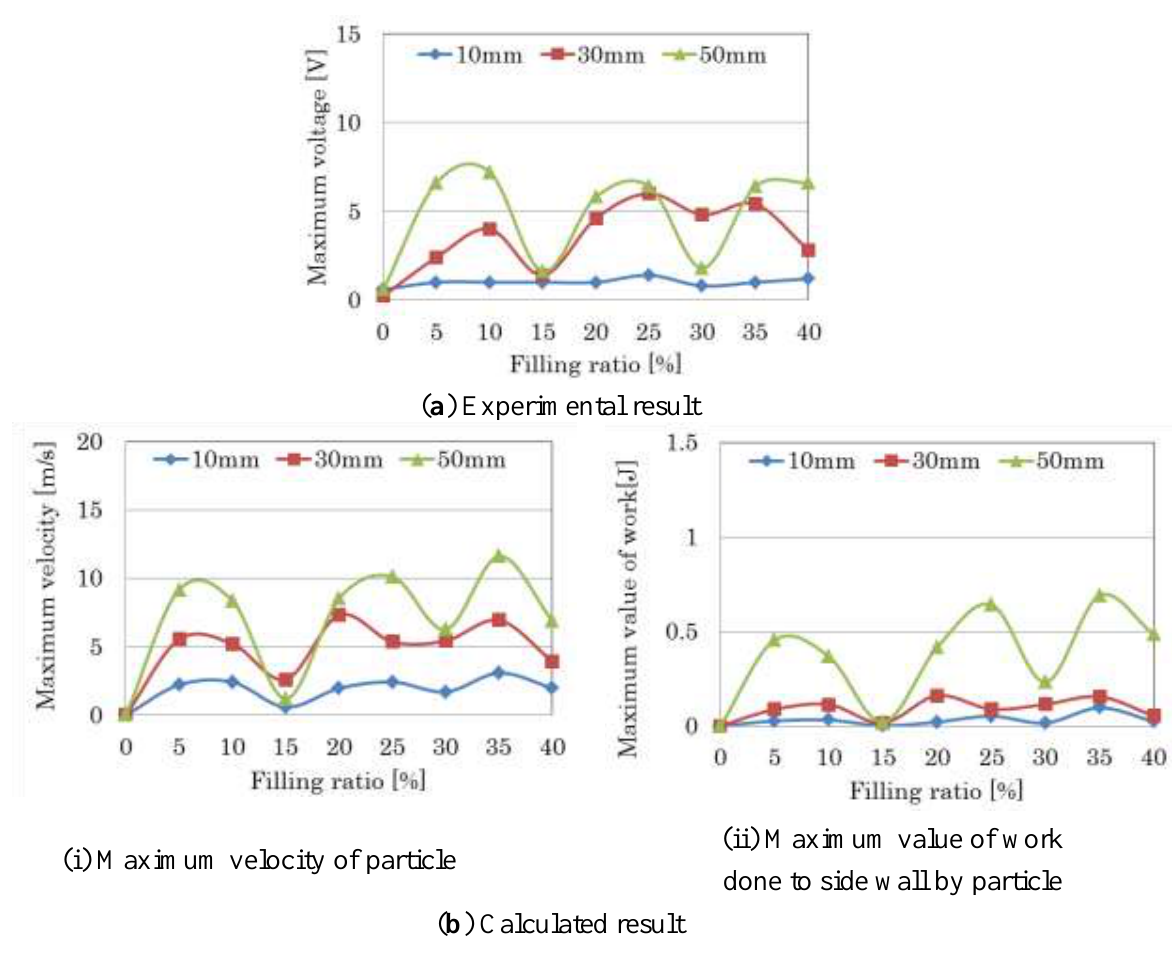
Figure 5. Relationship between double amplitude of container and filling ratio ( P d = 12.7 mm, f = 7